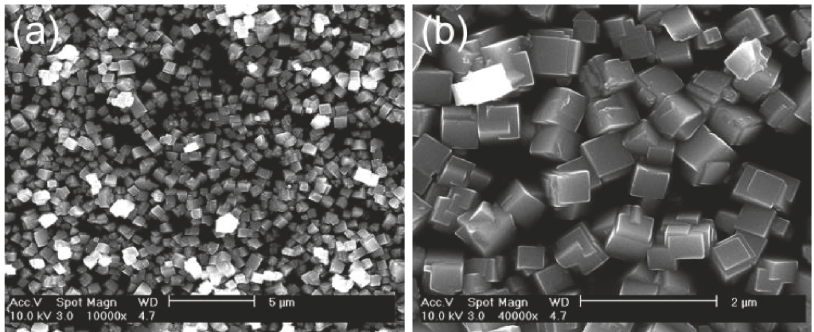
Figure 4: FE-SEM images of the Prussian blue nanocrystal synthesized (a) at a lower magnification and (b) at a higher magnification.